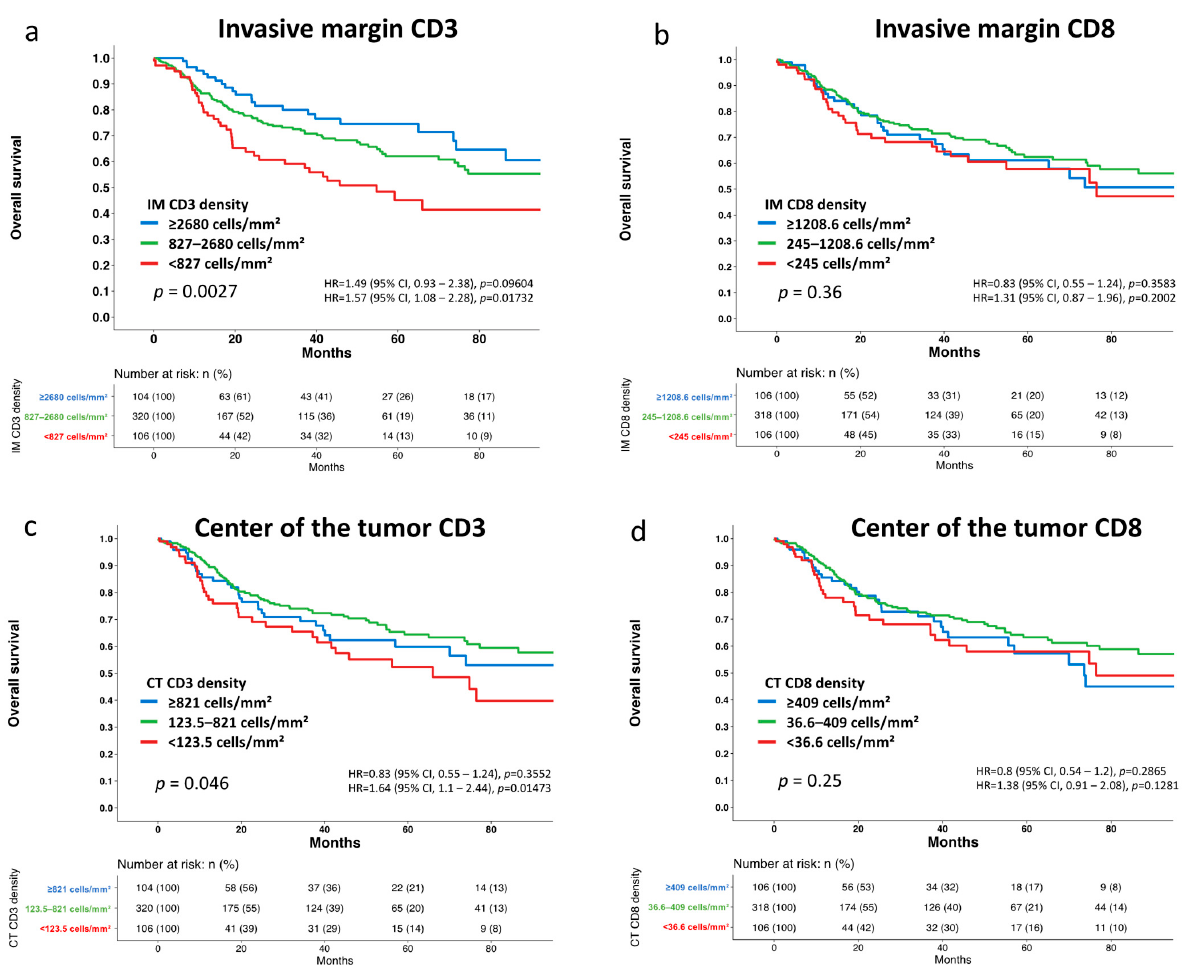
Figure 2. Kaplan–Meier Estimates for overall survival in vulvar cancer. Prognostic impact of